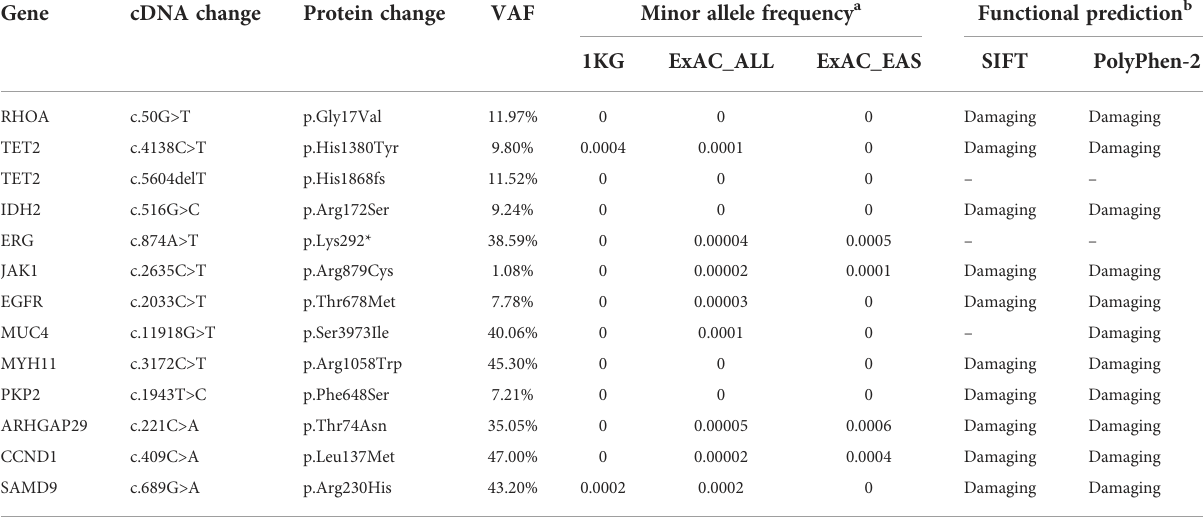
TABLE 1 Summary of the results for the targeted NGS